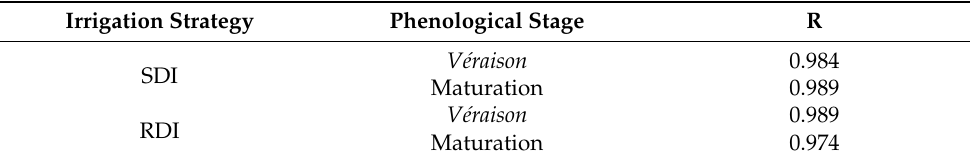
Table 1. Correlation between biological replicates. Irrigation strategies are RDI (regulated deficit irri- gation) and SDI (sustained deficit irrigation). Developmental stages are v é raison and full maturation; r represents the coefficient of correlation between replicates. Natural logarithm was applied to